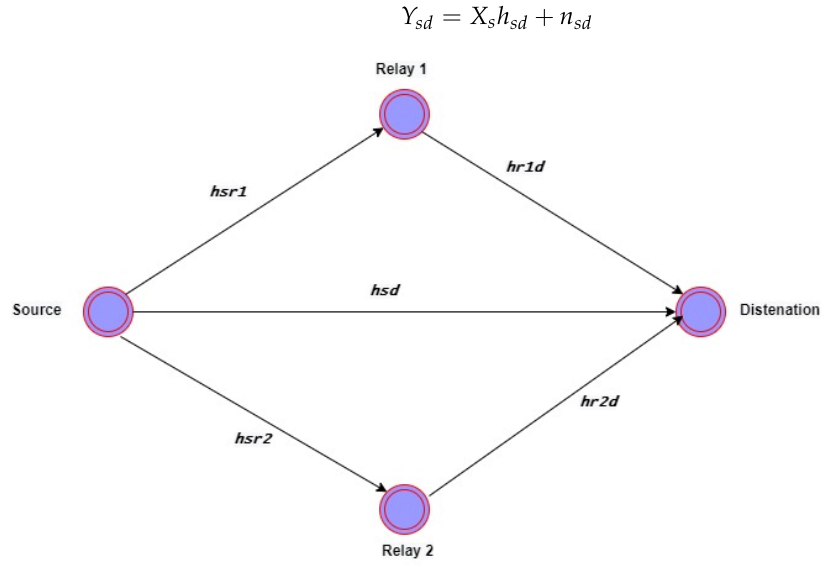
Figure 3. A simple model of cooperation.